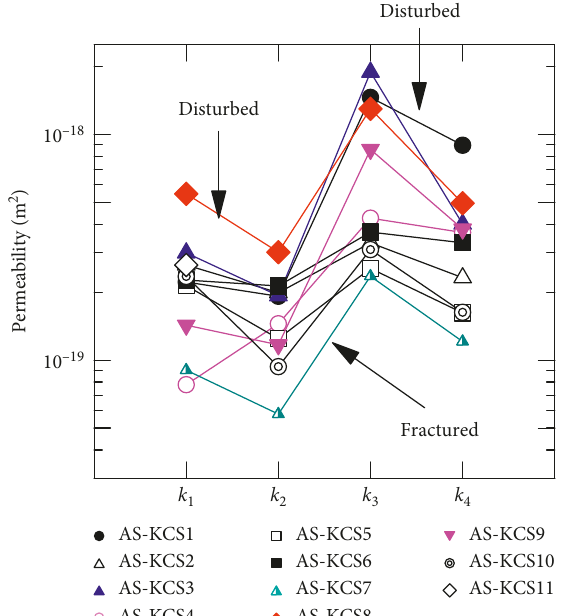
Figure 7: Variation in permeability in each hydrostatic stress state at the time of axial stress disturbances and triaxial